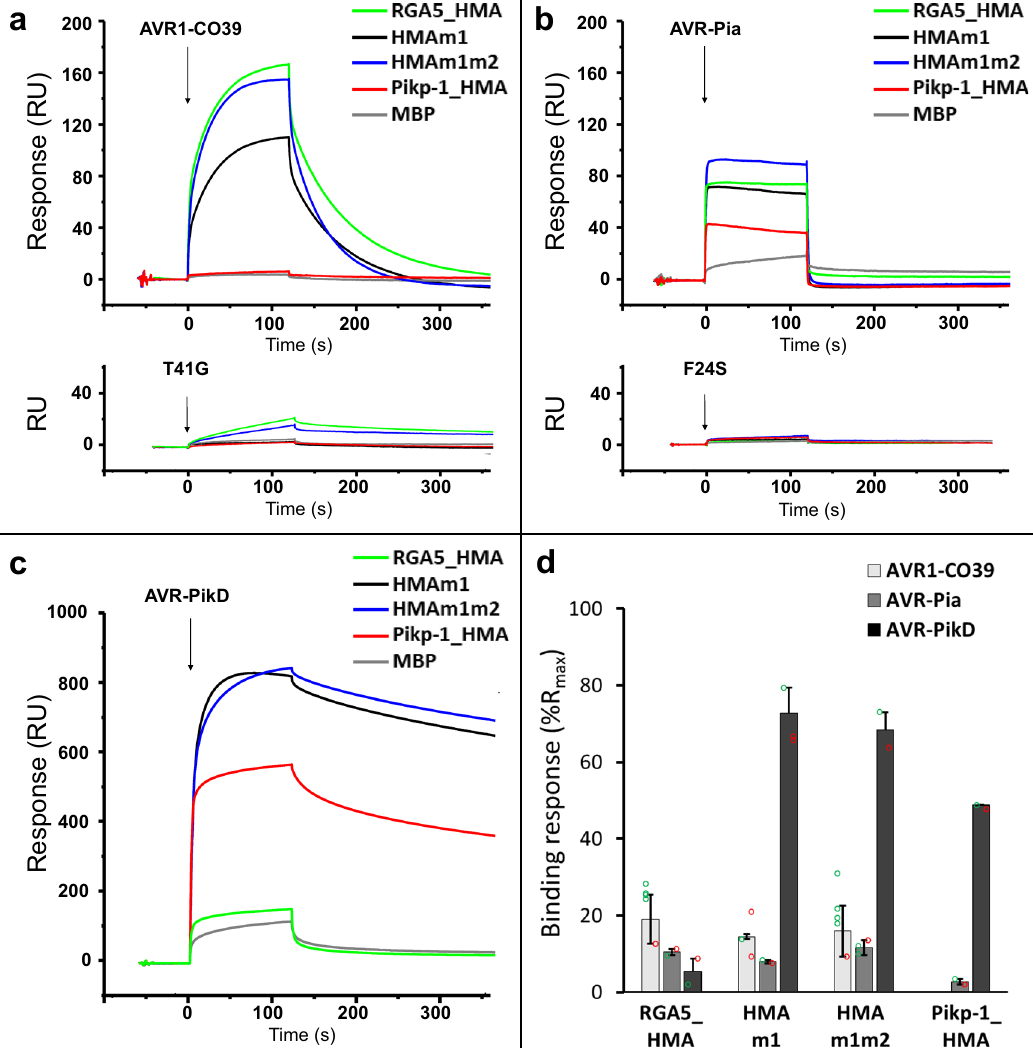
Fig. 3 Engineered RGA5_HMAs bind strongly to AVR-PikD in vitro. a – c AVR1-CO39 ( a ), AVR-Pia ( b ), and AVR-PikD ( c ) were injected (black arrows) at 1 µ M for 2 min on the different MBP:HMA fusion proteins captured by anti-MBP antibody immobilized on the chip. Superimposed sensorgrams are shown for wild-type RGA5_HMA (green), RGA5_HMAm1 (black), RGA5_HMAm1m2 (blue), Pikp-1_HMA (red), as well as for MBP alone (gray) that serves as a negative control. The binding curves obtained with the wild-type and an inactive variant of AVR1-CO39 ( a ) or AVR-Pia ( b ) are shown in the top and lower insets, respectively. d Comparison of the binding response (bound fraction) at 1 µ M of AVR effectors, expressed as the percentage of the theoretical maximum response (%Rmax) normalized for the amount of MBP:HMA immobilized on the chip and corrected for the MBP-tag contribution. Bars and error bars represent the mean and average deviation calculated for the %Rmax values estimated from n = 2 independent experiments carried out on two different days (open green and red circles) wit n = 1 to n = 4 technical replicates per experiment. Two independently puri fi ed protein samples were used to test the binding of the AVR-PikD effector to the different